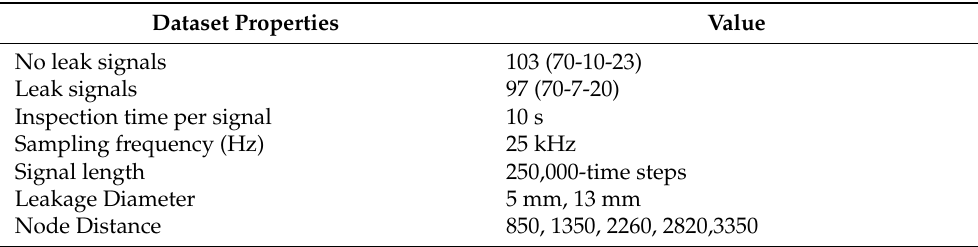
Table 5. Dataset